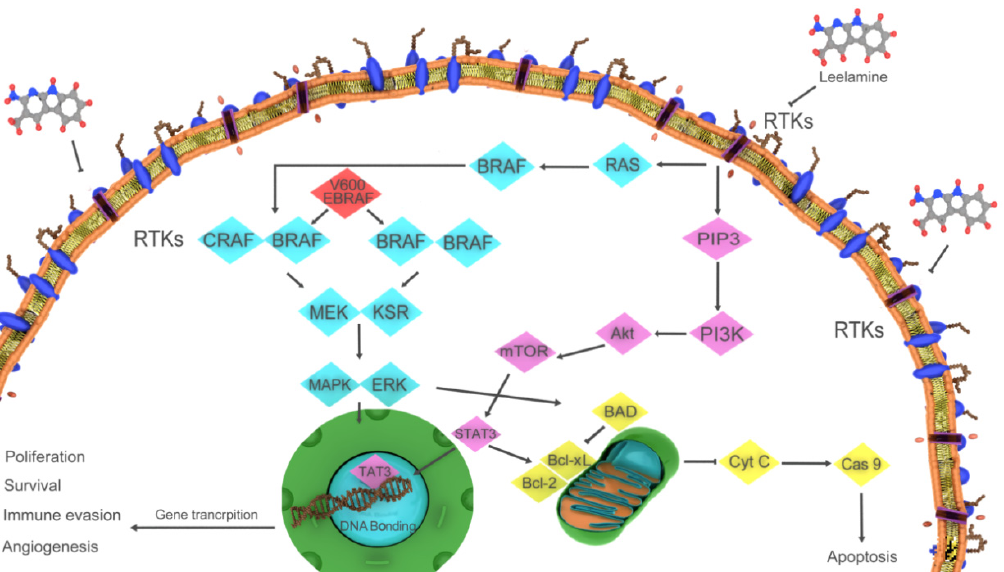
Figure 5. Mechanism of action of leelamine. Leelamine disrupts receptor tyrosine kinase signaling pathways, leading to a decrease in the phosphoinositide 3-kinase/protein kinase B, mitogen-activated protein kinase, and signal transducer and activator of transcription 3 signaling cascades, resulting in the reduction of B cell lymphoma (Bcl) 2 and Bcl-extra-large expression levels.